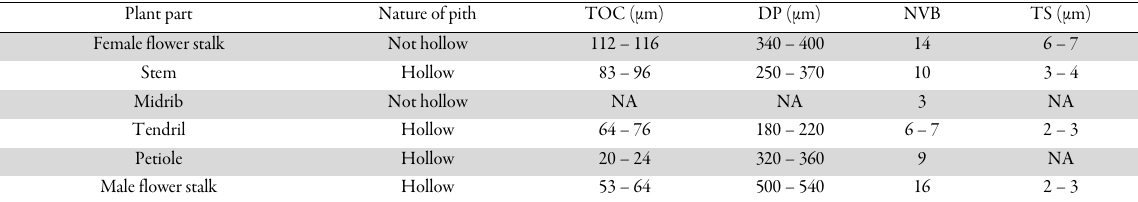
Table 2. Anatomical Characteristics of B.